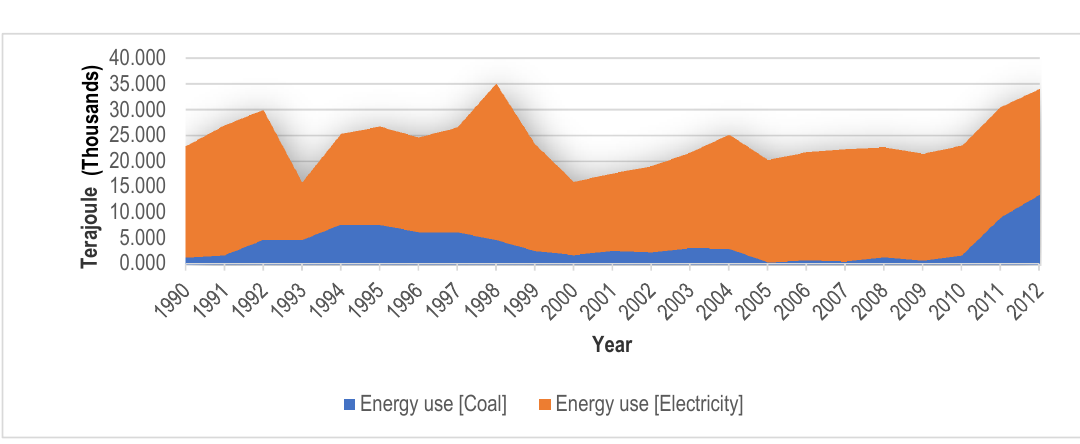
Figure 2. Energy use in South Africa’s agriculture sector (the energy use does not take into account energy from methane and fuel oils, which contribute more than 50% of energy use in South Africa’s agricultural sector [17]). Source: FAOSTAT [22].